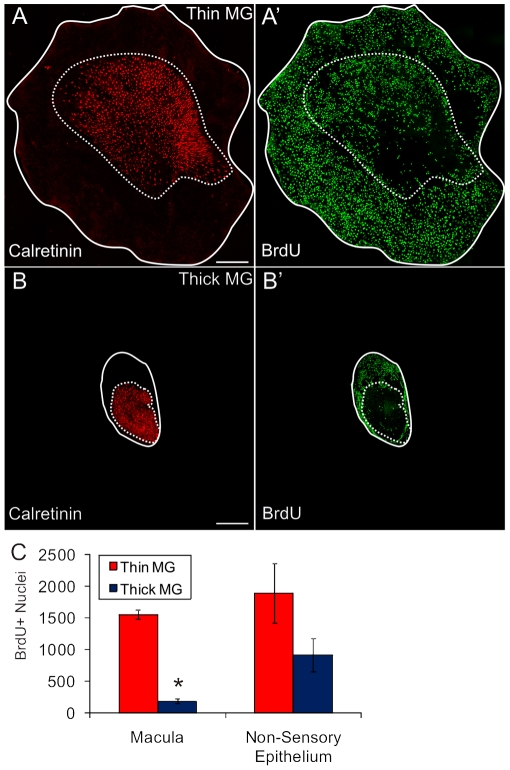
Cells within spread maculae enter S-phase.(A–B) Z-projected confocal image stacks of delaminated utricular epithelia from E18 mice immunolabeled with antibodies for the hair cell marker, Calretinin (red) after being cultured on thin (A) or thick (B) Matrigel for 72 hours. BrdU (green) immunolabeling is shown in A′ and B′. BrdU+ nuclei are largely restricted to the non-sensory epithelium on the thick Matrigel, but BrdU+ nuclei are present throughout the macula (edges marked with dashed line) and non-sensory epithelium (edges marked with solid line) after spreading on thin Matrigel. Scale bars, 300 µm. (C) Quantification of the number of BrdU+ nuclei in maculae and non-sensory epithelia from cultures on thick MG and thin MG is shown (n = 4). There is a significant increase in the number of BrdU+ nuclei within the sensory epithelium of cultures grown on thin MG compared to cultures grown on thick MG (p<0.0001; Student's t-test).